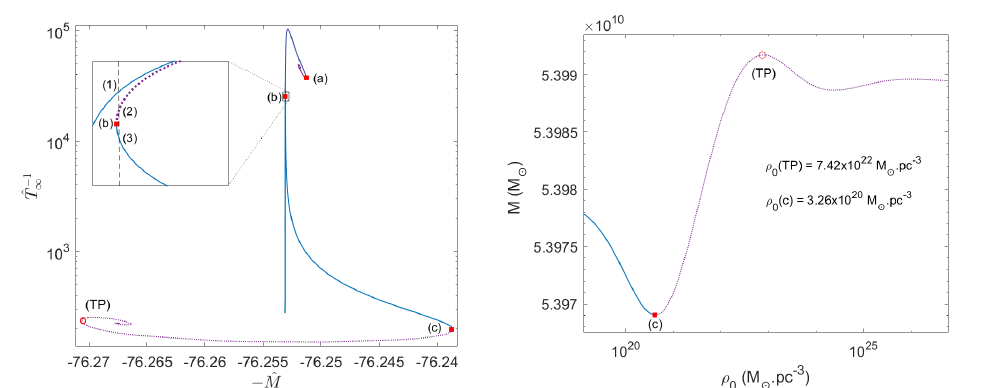
Figure 13. ( Left ): Equilibrium solutions along the caloric curve for tidally truncated configurations of mc 2 = 48 keV fermions with fixed N . The states within the continuous blue branches are ther- modynamically (and dynamically) stable (i.e., either local or global entropy maxima), while the dotted violet branches − between (a) and (b) and after (c) − are unstable (i.e., either minimum or saddle point of entropy). Solution (3) is stable and fulfills the virialization conditions. The second spiral of relativistic origin for high T ∞ is characteristic of caloric curves at fixed N within general relativity. It implies the existence of a turning point in a mass − central density curve (see right panel). ( Right ): Equilibrium states with N > N OV along the M vs. ρ 0 curve, in correspondence with the caloric curve of the left panel. The last stable configuration at the onset of the core collapse occurs at the minimum of this curve and prior to the turning point instability (corresponding with point ( c ) in the left panel). Such a critical solution has a core mass M cr c ≈ 2 × 10 8 M (cid:12) , thus forming an SMBH from DM core collapse. Reproduced from [11] with the authors’ permission.